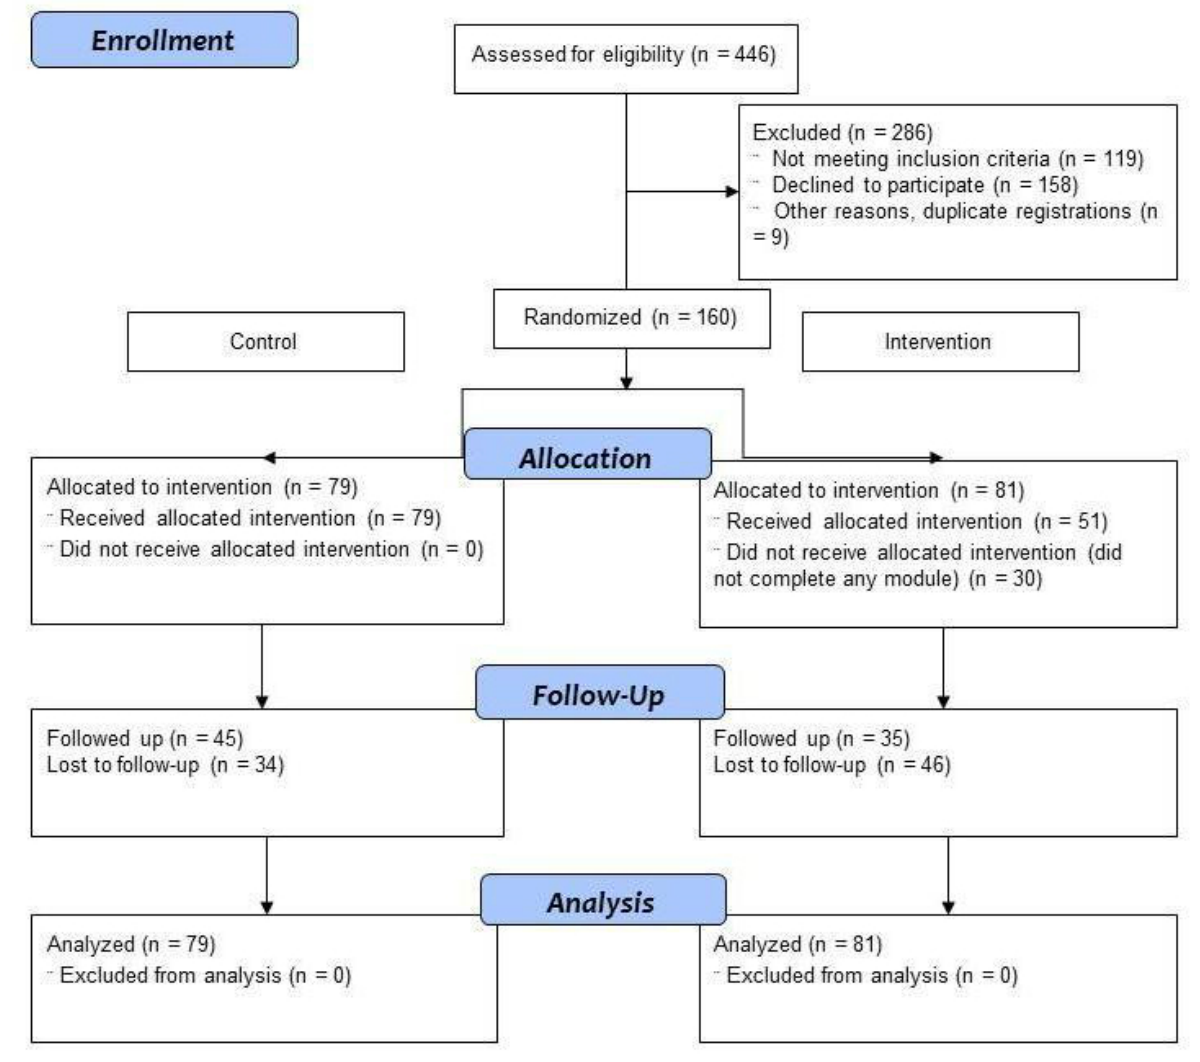
Figure 1. CONSORT flow